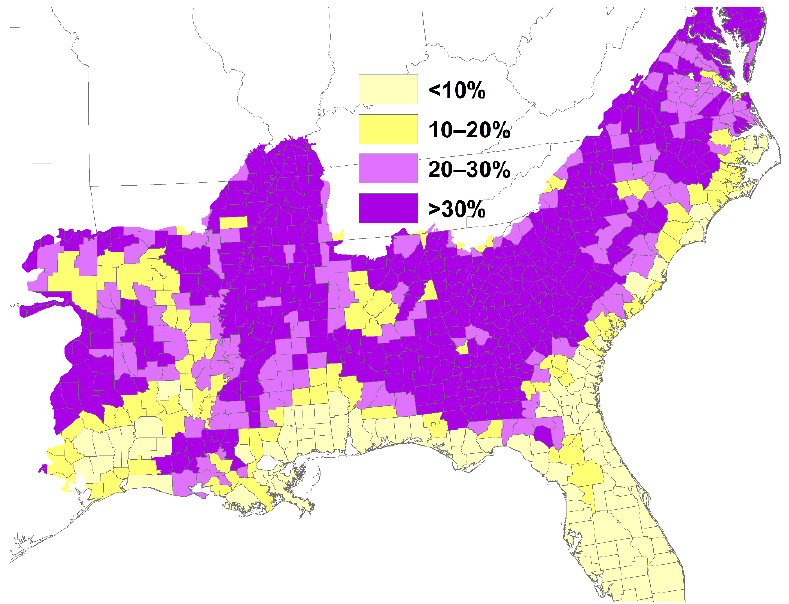
Figure 2. Percent of land in agriculture by county during 1920 (modified from [38]).